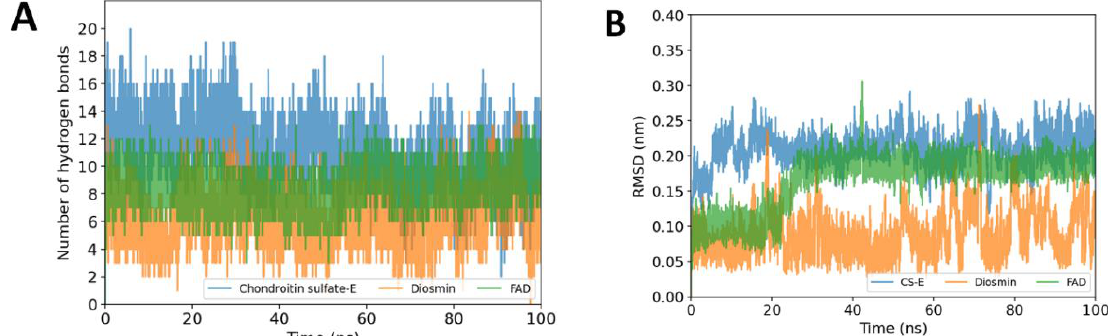
Figure 6. Stability and interactions of the two top hit compounds versus the native ligand CS-E during 100 ns MD simulations: ( A ) The number of hydrogen bonds occurred between the hit compounds and the MPXV E8 protein. ( B ) The RMSD values of ligand heavy atoms.